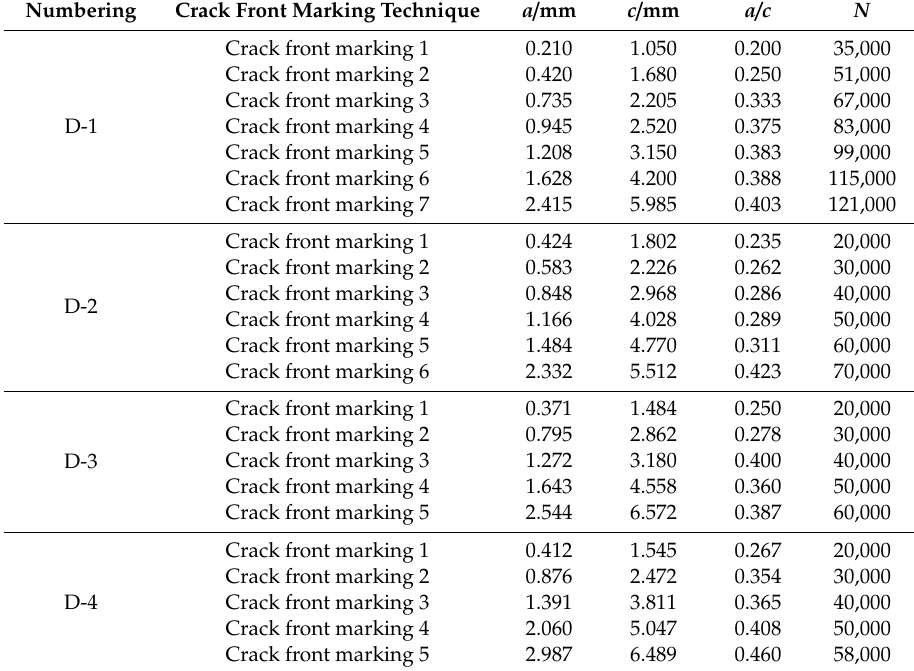
Table 3. Test data of steel wire crack propagation with notches of different depths. Numbering Crack Front Marking Technique